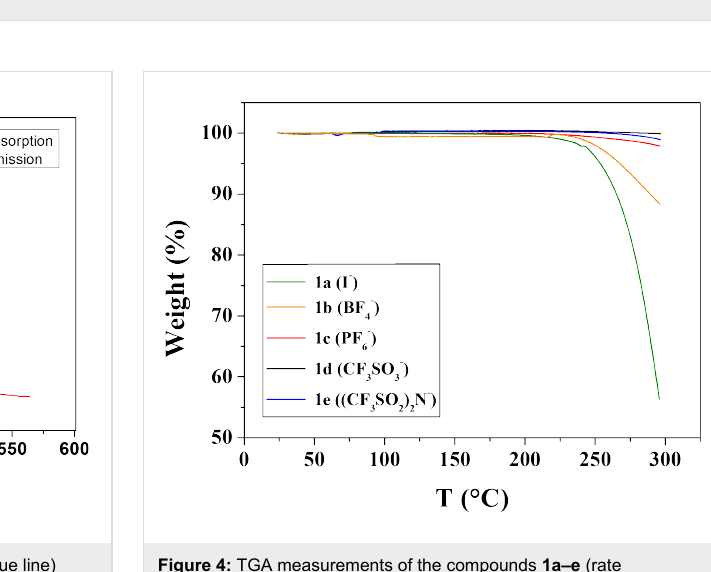
Scheme 4: Anion metathesis in water/CH 2 Cl 2 as solvent.